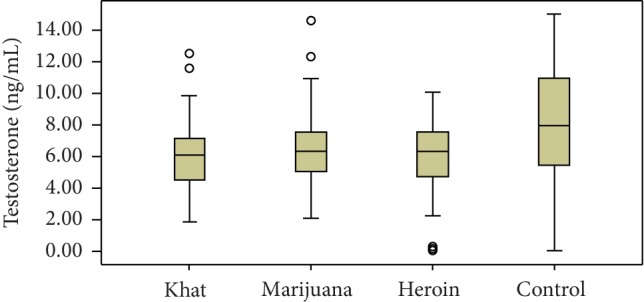
Box and whisker plot data comparison graph of median testosterone hormone levels among khat, marijuana, heroin, and control groups.